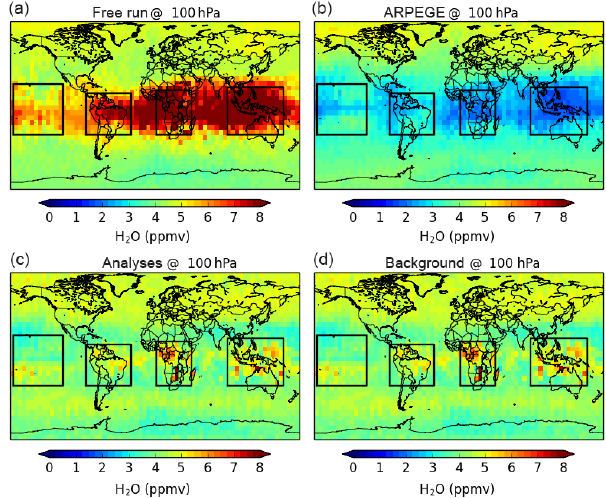
Figure 14. Monthly averaged H 2 O fields at 100hPa in January 2012 in the MIPAS observation space (in time and space coinci- dence with MIPAS observations) from the free run (MOCAGE, a ), ARPEGE (b) , MLS analyses (assimilation, c ) and the back- ground (d) .